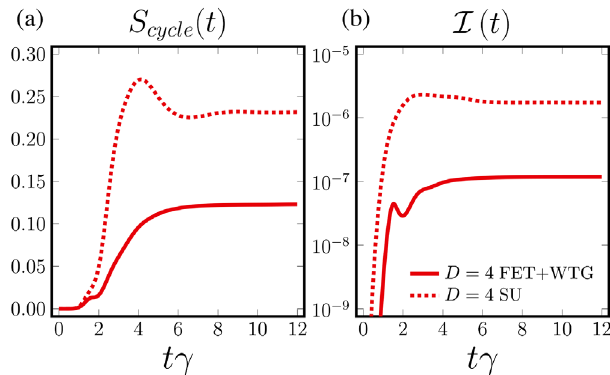
FIG. 6. (a) Accumulation of internal correlations in time t Þ , which is more effectively quantified by the cycle entropy S cycle ð curtailed by FET þ WTG. (b) Infidelity of truncation I ð t Þ , which is an order of magnitude smaller than SU at each truncation step. The results form a moderately damped regime of the dissipative Ising model V= γ ¼ 1 . 2 , h x = γ ¼ 0 . 0 with D ¼ 4